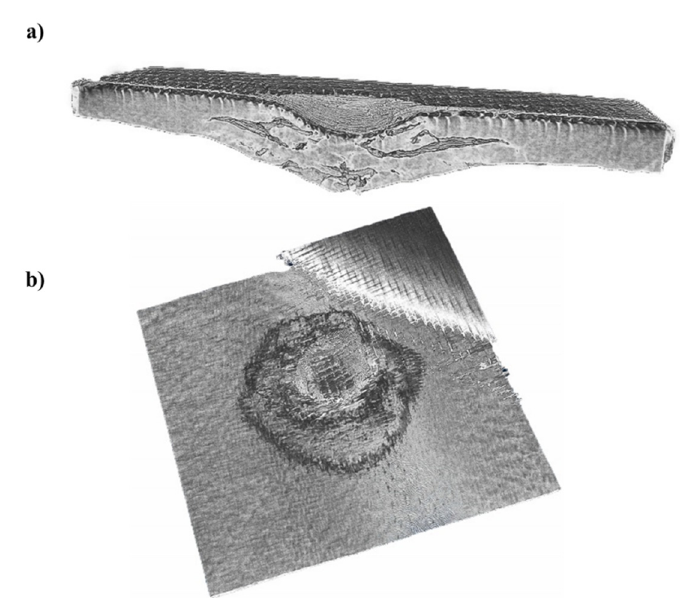
Figure 16. Micro CT scan pictures of a flax/basalt hybrid composite after an impact test, with a 50 J impact energy: ( a ) half-view of the specimen with impact failure, in the form of delamination, and ( b ) top view of the damaged area’s shape.